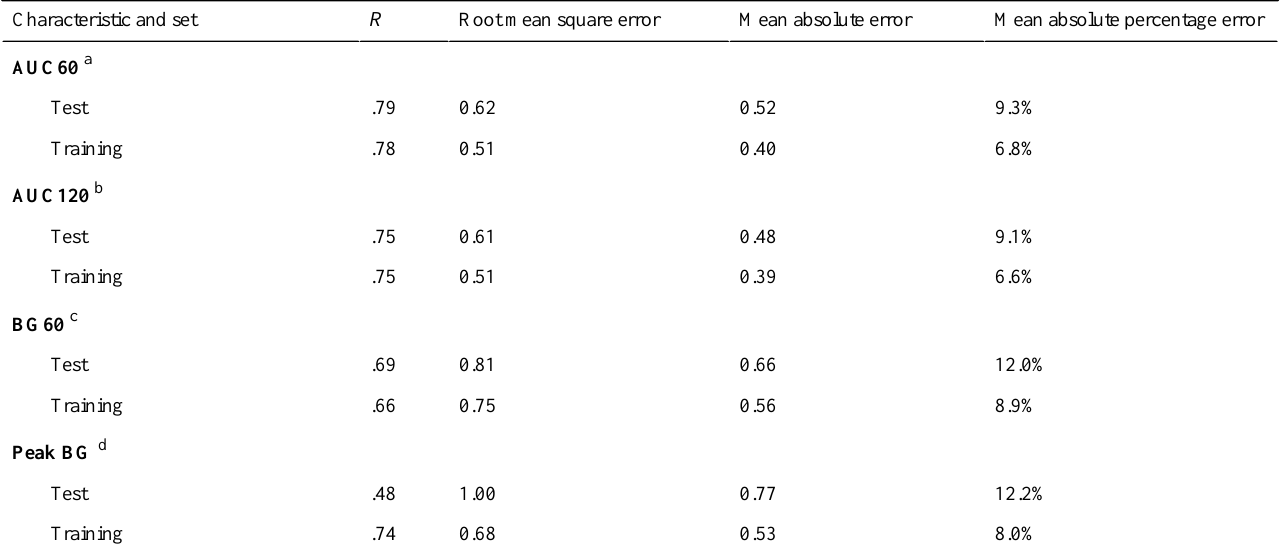
Table 4. Estimation of model